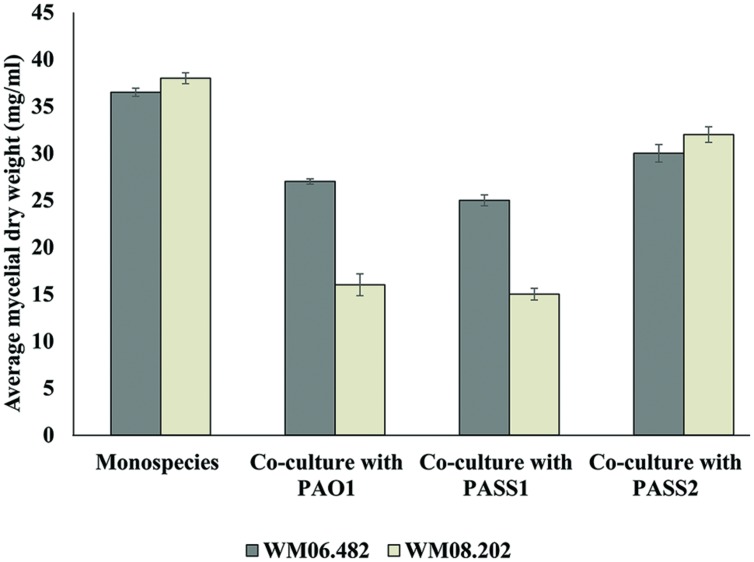
The inhibitory effect of P. aeruginosa on S. aurantiacum during co-culture in SCFM, determined by the change in dry weight of S. aurantiacum hyphae. A sterile polycarbonate membrane was used to separate P. aeruginosa from S. aurantiacum in six well culture plates. Error bars on each data point represent SEM of three independent experiments. P-values were calculated by student’s t-test, where p < 0.05 was considered significant.